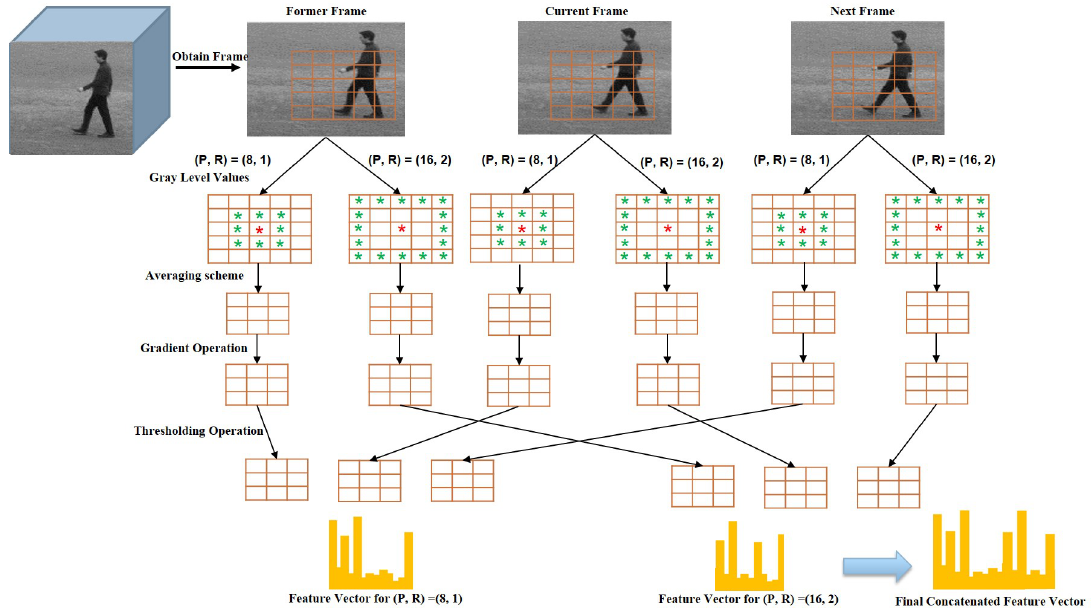
Figure 5. The Multi-resolution approach of WVLGTP.